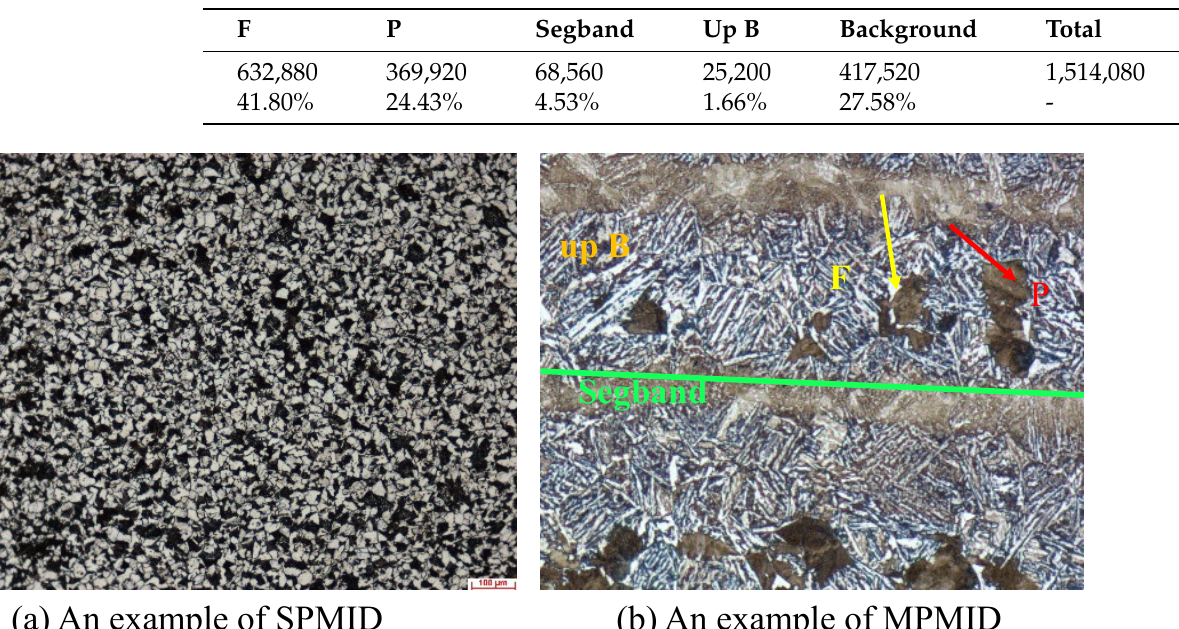
Table 3. The data distribution of dataset Multi-Phase Metallographic Image Dataset (MPMID). The first row is the number of pixels, and the second row is the proportion.